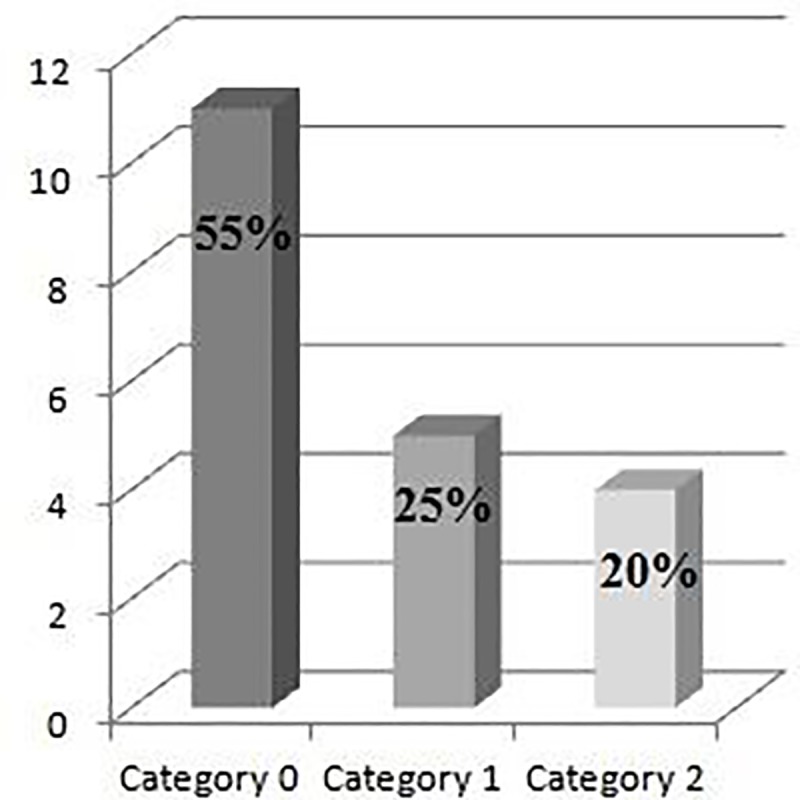
Chart showing the prevalence of arrhythmias in the G1 according to the categories established on the Holter exam.